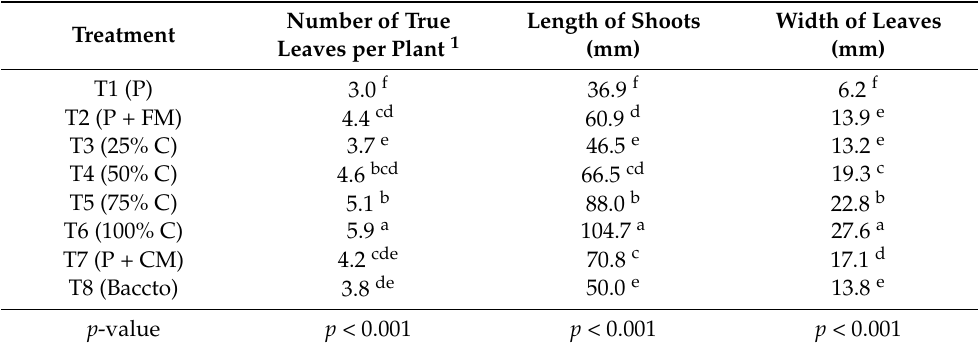
Table 3. Effect of different potting media treatments on the growth of beet seedlings, 36 days following seeding ( n =